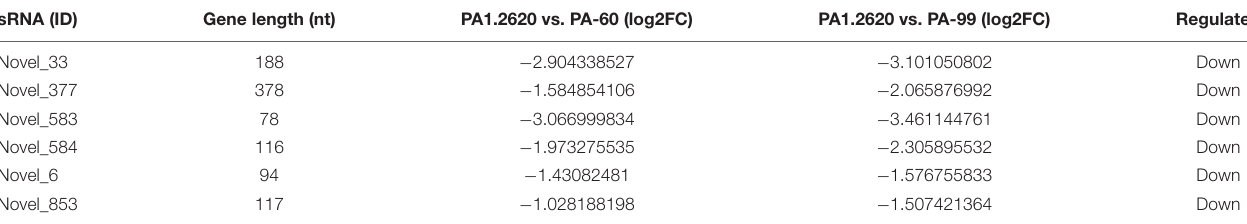
TABLE 3 | Co-expressed differentially expressed sRNA of HL